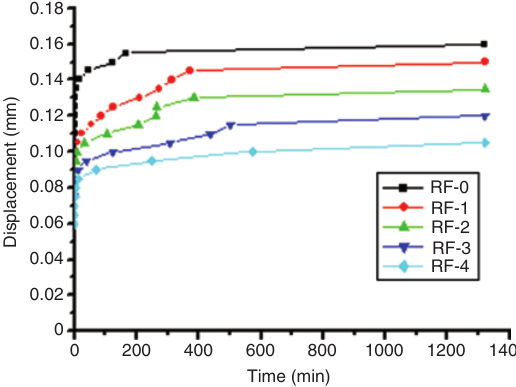
Figure 9 Creep behavior of CR reinforced with a varying number of polyester tire-cord